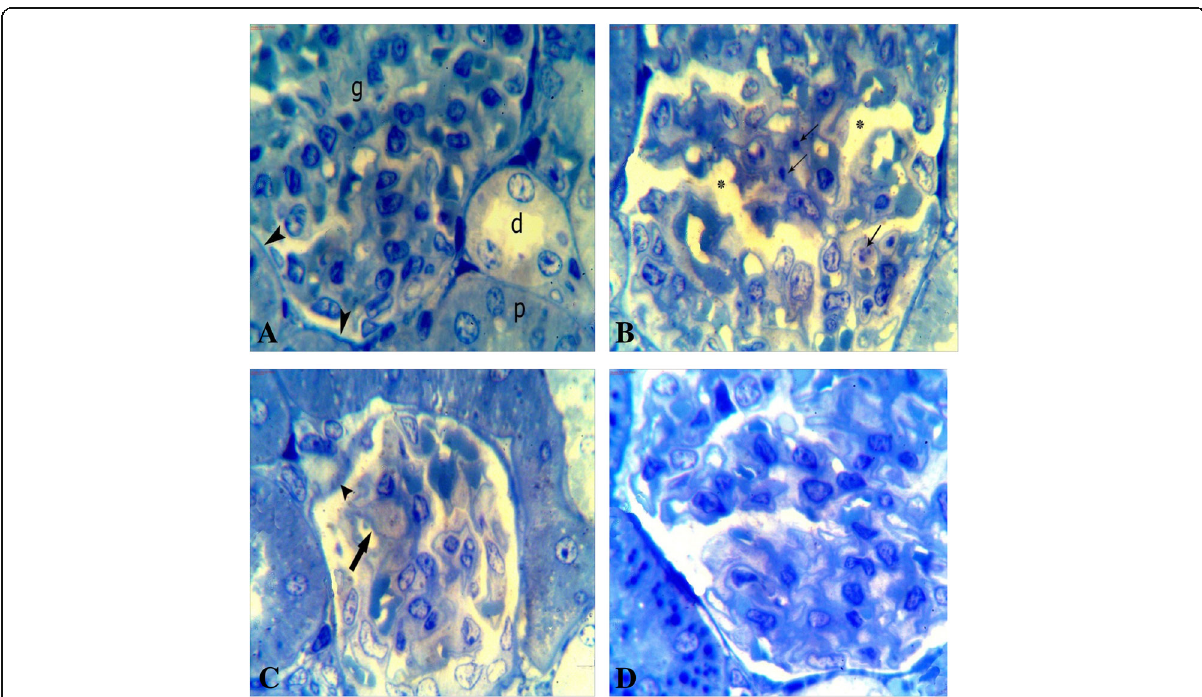
Fig. 3 Photomicrographs of a semithin section in the kidney tissues a A section in control group showing a healthy look of the glomerulus (g), distal tubules (d), and part of a proximal tubule (p), a typically tinny parietal layer of the Bowman ’ s capsule (arrowheads). b A section in CA group showing necrotic cells with an intense and degenerated nuclei (thin arrows), shrinkage and degenerate of the capillary network resulting in widening the spaces (asterisks). c A section in CA group showing a degenerated capsule with thickened of capillary walls (thick arrows) and a decreased in capillary tights, some capsules epithelia cells are degenerated (arrowheads). d A section in CA + FU group showing more or less healthy looking of the glomerulus (Toluidine blue. ×